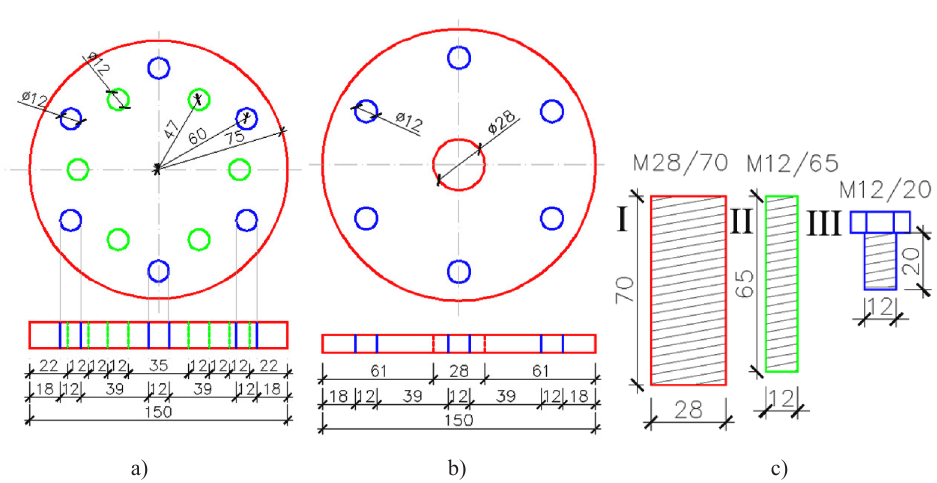
Fig. 3. Steel plates and bolts used for fixing the specimens in the torsion testing machine: a) bottom plate, b) top plate, c) bolts (dimensions in mm)